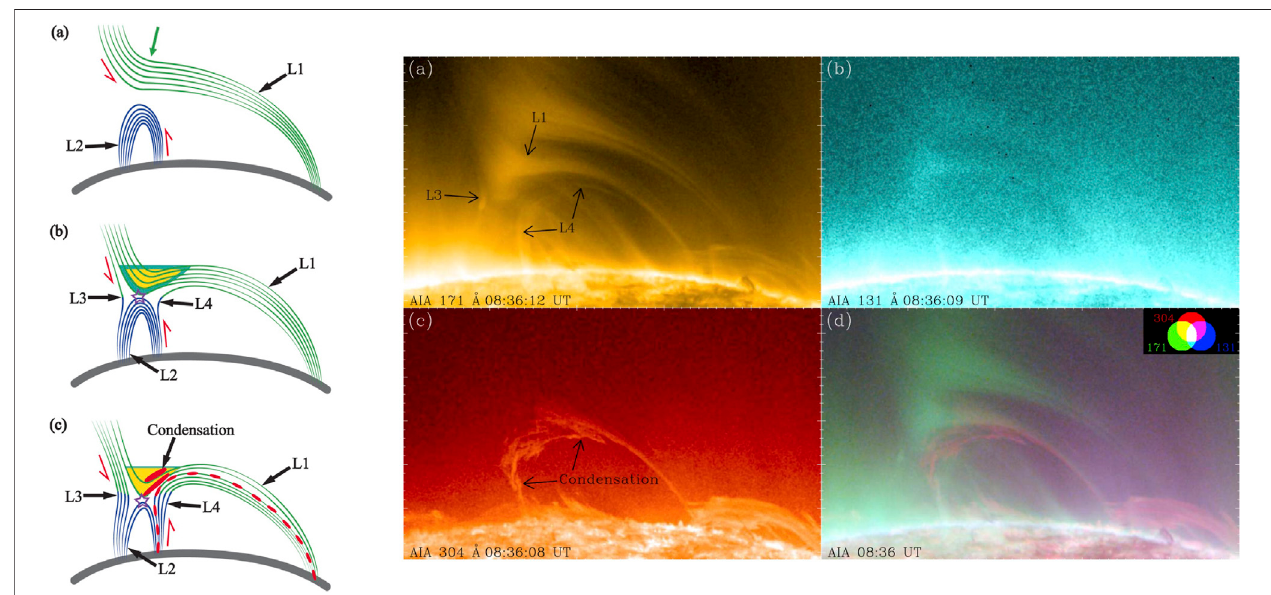
FIGURE 15 | Hybrid prominence/coronal rain structure. Left: A sketch of the structure. Magnetic fi eld lines in green (L1) form a dip where plasma can settle and catastrophically cool to form condensations. The material can spill down along L1 as coronal rain. Magnetic reconnection can take place with coronal loops below (L2), caseinwhichthecoolmaterialcanslipthroughandfallascoronalrain.Newsetsofloops(L3andL4)formthroughreconnection,andcanalsocarrywiththempartofthe condensed material. Thegreenlines (L1) canbe open orclosed.If open,then the reconnection isofan interchange type. Right: A 4-panel fi gure showing, from top to bottom and left to right, AIA/171, AIA/131, AIA/304 and a composite image of all 3. An X-type structure can be seen, in which the cool material (seen in 304) accummulates and rains down. Both fi gures are adapted from Li et al. (2018) (Figures 5,6 © AAS. Reproduced with permission.).